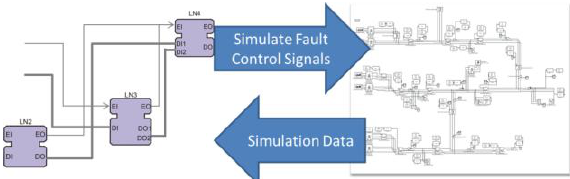
Figure 12. Close-loop co-simulation for validating the generated control system with the plant model in Matlab Simulink.